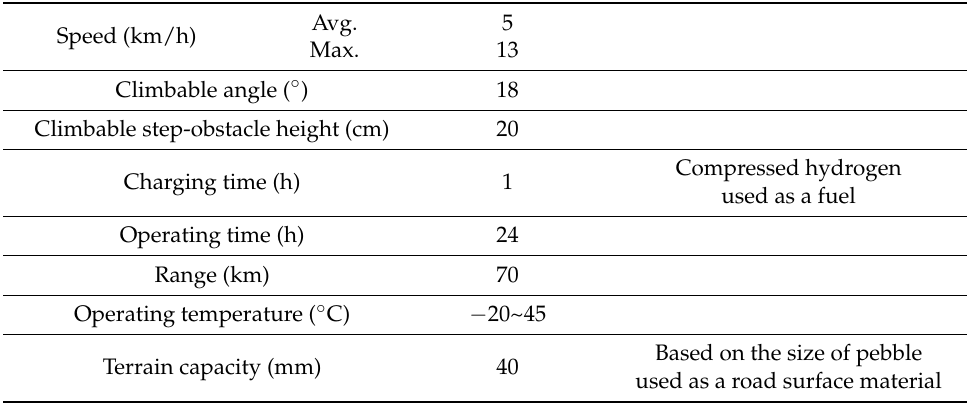
Table 2. Security robot’s requirements pertaining to